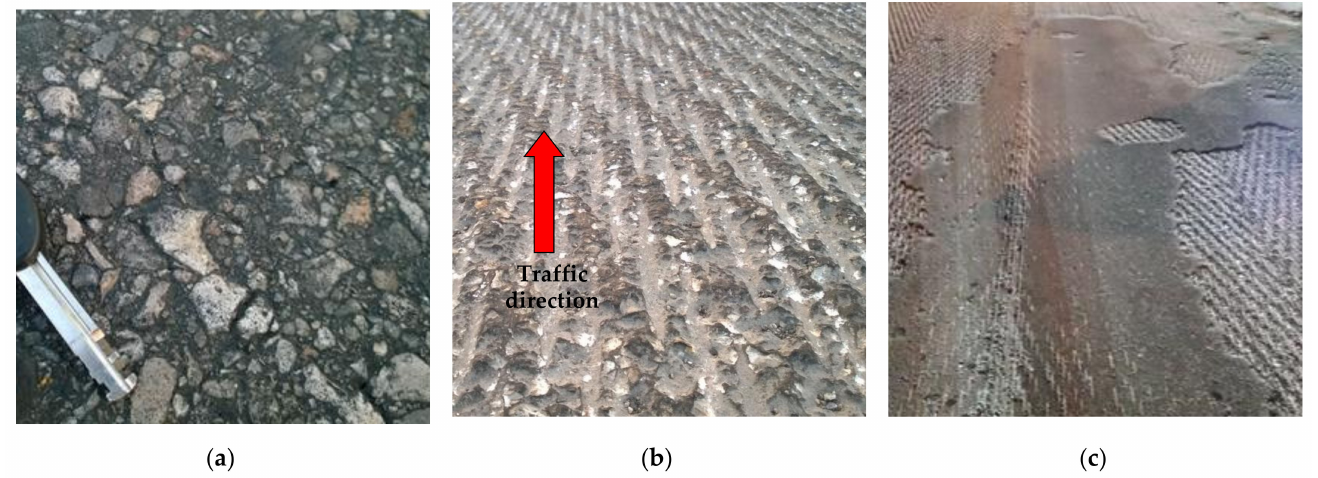
Figure 2. Surface conditions of US 183 field project including: ( a ) existing; ( b ) uniformly milled; and ( c ) scabbed-milled surfaces. Two trackless tacks (Tack B and D) were used in the field. The three application rates used are 0.18, 0.32, and 0.45 L/m 2 (0.04, 0.07, and 0.1 gal/yd 2 ), in addition to no